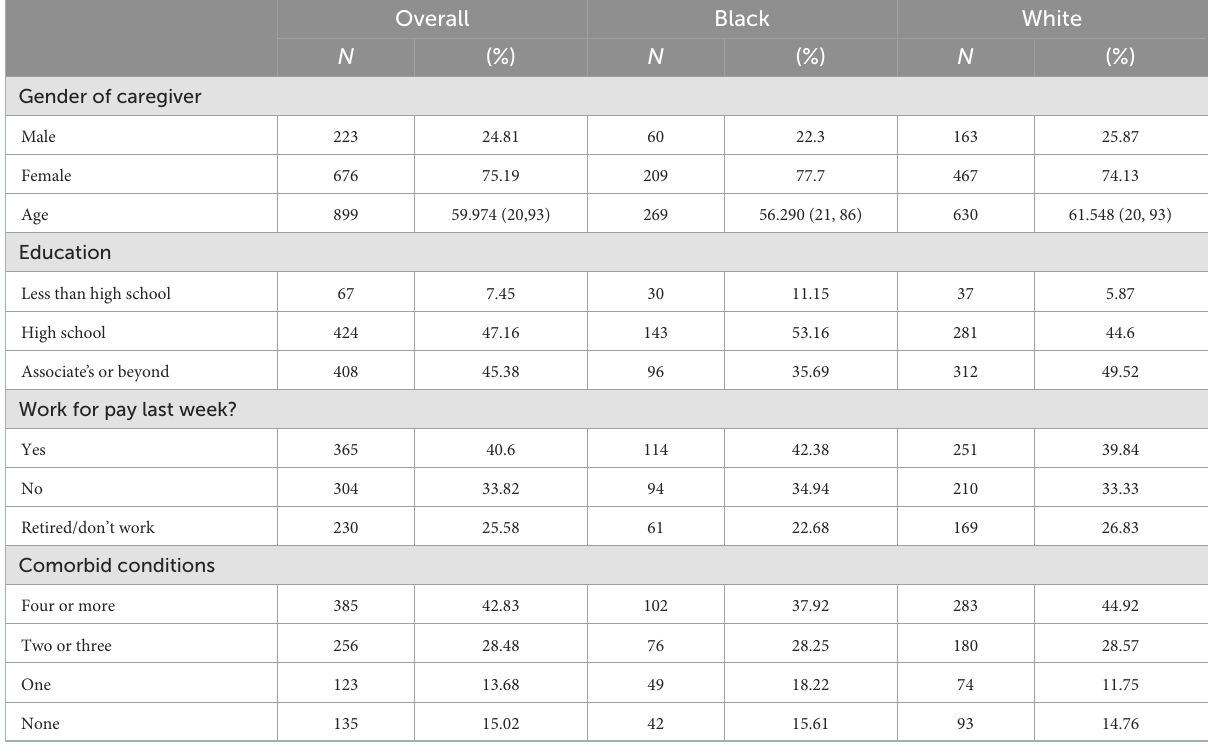
TABLE 2 Life has meaning and purpose and